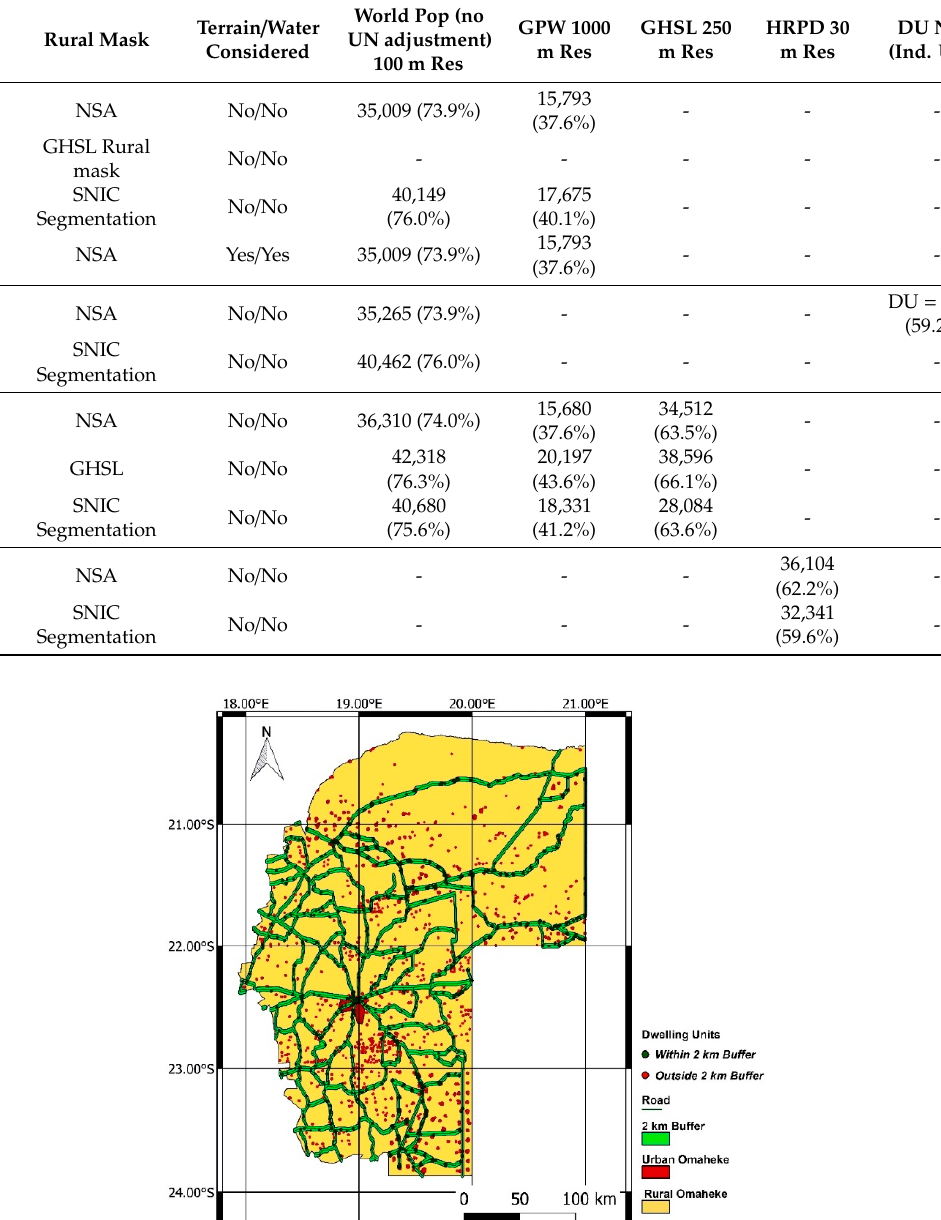
Table 8. 2 km RAI estimated with di ff erent datasets in Omaheke.